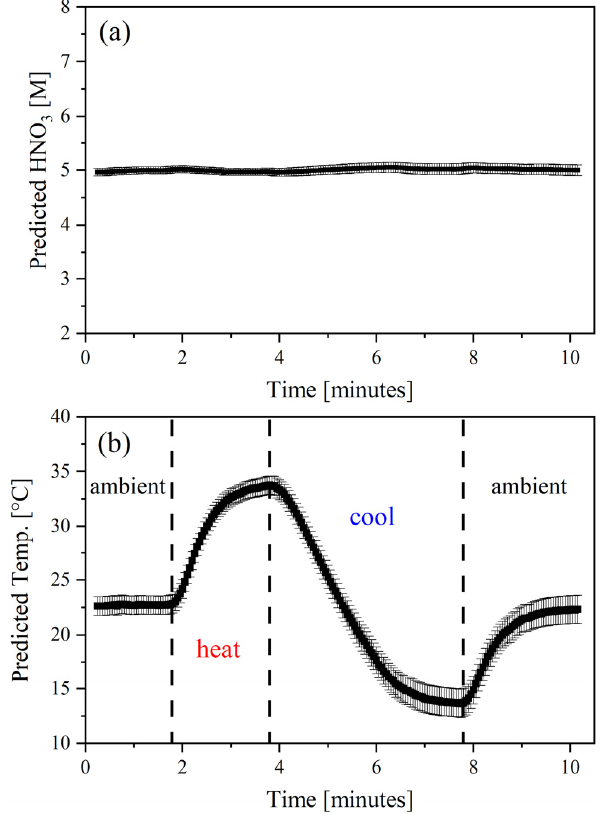
Figure 3. PLSR predicted HNO 3 ( a ) concentration (5 M) and ( b ) temperature (Temp., °C) during fl ow experiments.